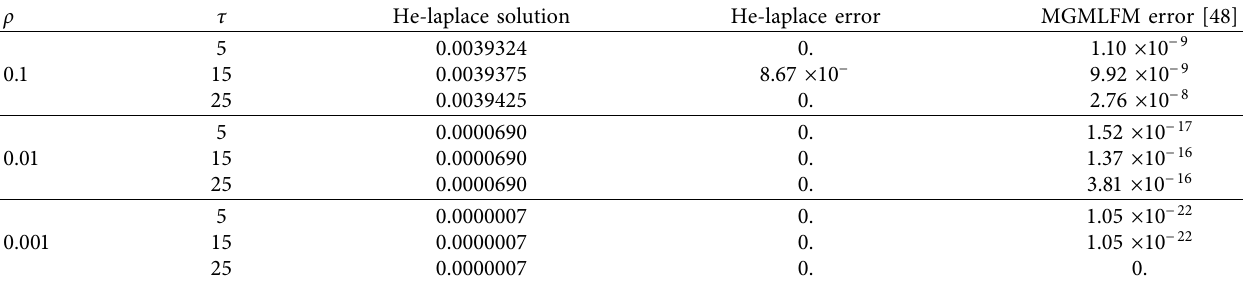
Figure 8: Effect of ρ on the solution profile in Example 2 when α � 0.5 and x � 7. Table 5: Comparison of He-laplace algorithm with MGMLFM in Example 3, when α � 1 and x � 30.